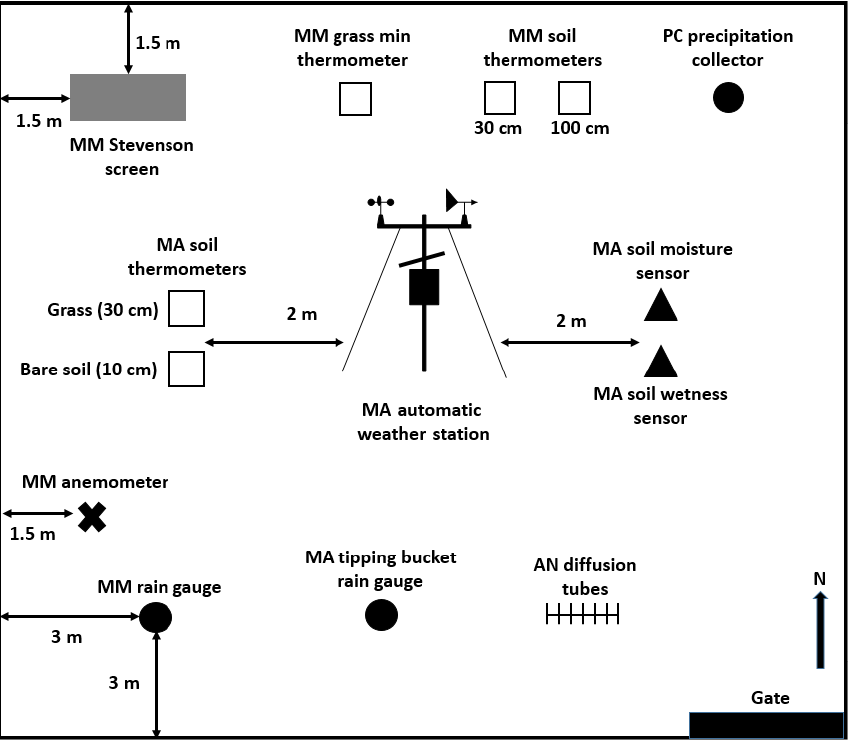
Figure 2. ECN meteorological enclosure (MA: automatic weather station; PC: precipitation chemistry; AN: atmospheric nitrogen; MM: manual meteorology).